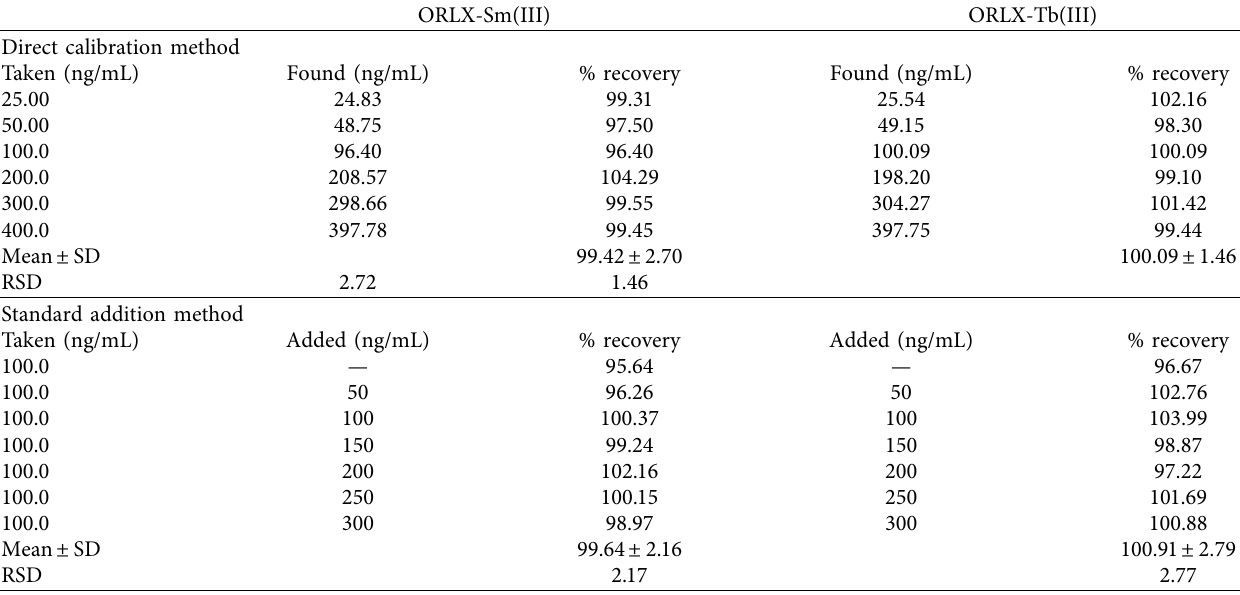
Table 9: Determination of ORLX in the formulation under the optimum conditions. Direct calibration and standard addition methods were performed.